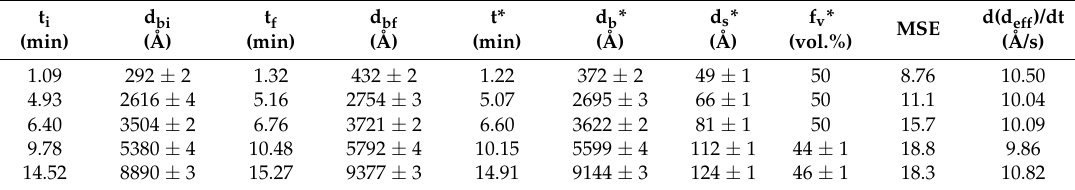
Table 4. Details of multi-time RTSE analysis that provides the structural evolution and b-spline ( ε 1 , ε 2 ) spectra for the IGS deposition with composition x = 0.30 on Mo-coated SLG. Selected initial, center and final times (t i , t* and t f ) for multi-time analysis are provided along with the associated bulk layer thicknesses obtained in the analysis from the best overall fit. Also given from the analysis are the center time surface roughness layer thicknesses and the void volume percentages in the surface layer. The mean square error values in the best fit multi-time analysis are shown in the second-to-last column. The deposition rates, given as the time derivatives of the IGS effective thickness (film volume/area) at t*, are provided in the last column. These effective deposition rates are larger than (d b * + 0.5d s *)/t* since the latter average rate does not include the time-independent interface IGS contribution of d i f IGS , and in addition, variations in rate can occur in the initial stages and throughout the deposition.